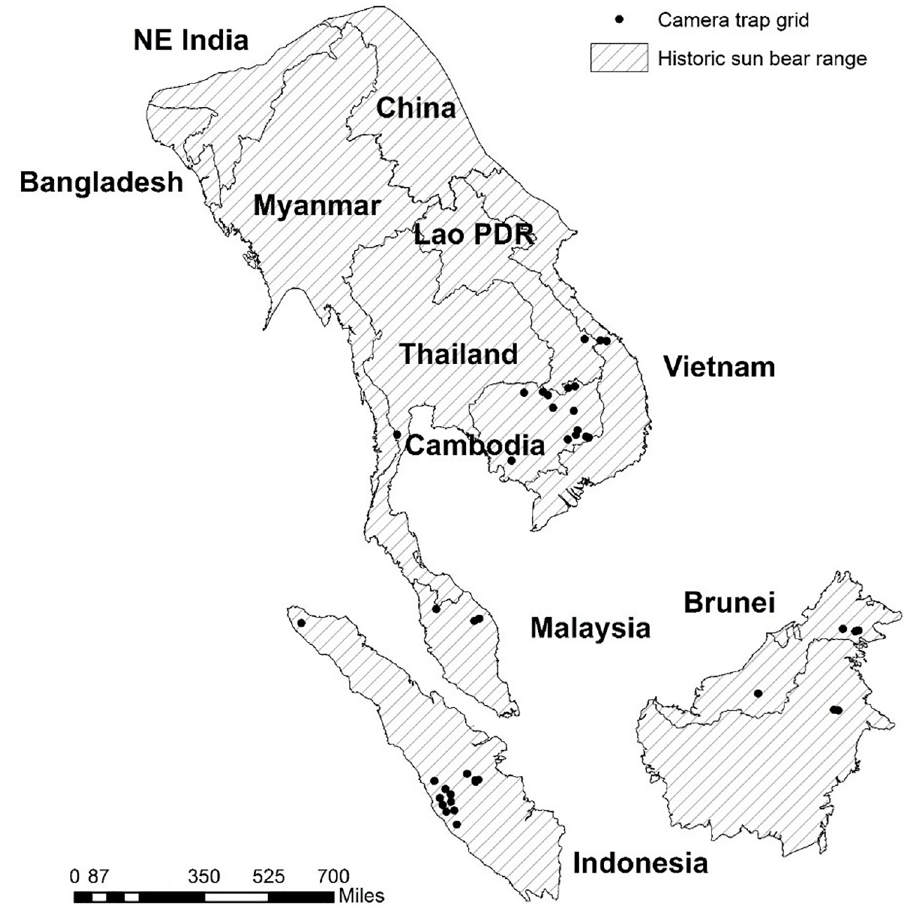
Fig 1. Sun bear range limits and distribution of cameratrap field sites from which sun bear detection data were collected between 2000–2015. Historic (within 500 years) sun bear range extends southwards, from southeast Bangladesh,northeast India and southernChina, throughoutmost of mainland southeast Asia, and all of Malaysiaand Indonesia[23]. Camera trap data, collected between2000–2015, were combinedfrom 7 out of 11 sun bear range countries to project range-widepopulationtrends using changesin tree cover between2000–2014.